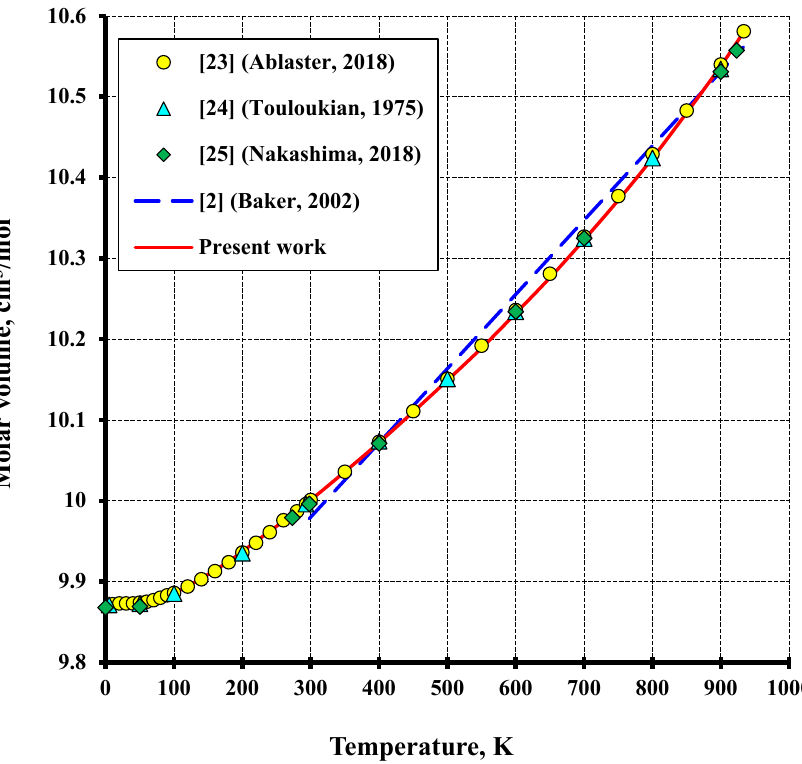
Figure 2. The molar volume of solid aluminum plotted versus temperature. Figure 3 illustrates the molar volume of aluminum plotted against pressures up to 1000 kbar. The experimental points totaled 113. The mean absolute deviation between the calculation and experiment over the entire pressure range was 0.018 cm 3 /mol, RMS = 0.30%. Table 5 compares the Tait equation of state parameters obtained herein with those from the literature. The calculated isothermal bulk modulus at 298.15 K was 728.6 kbar and is on par with the literature data listed in Table 5. Table 5. Equation of state parameters for aluminum.